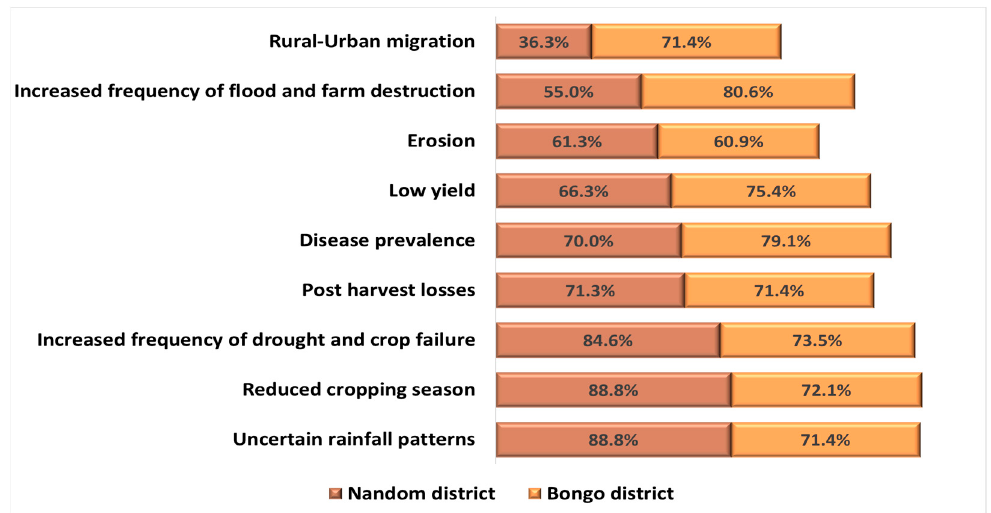
Figure 2. Negative e ff ects of climate change on farmers in the districts.